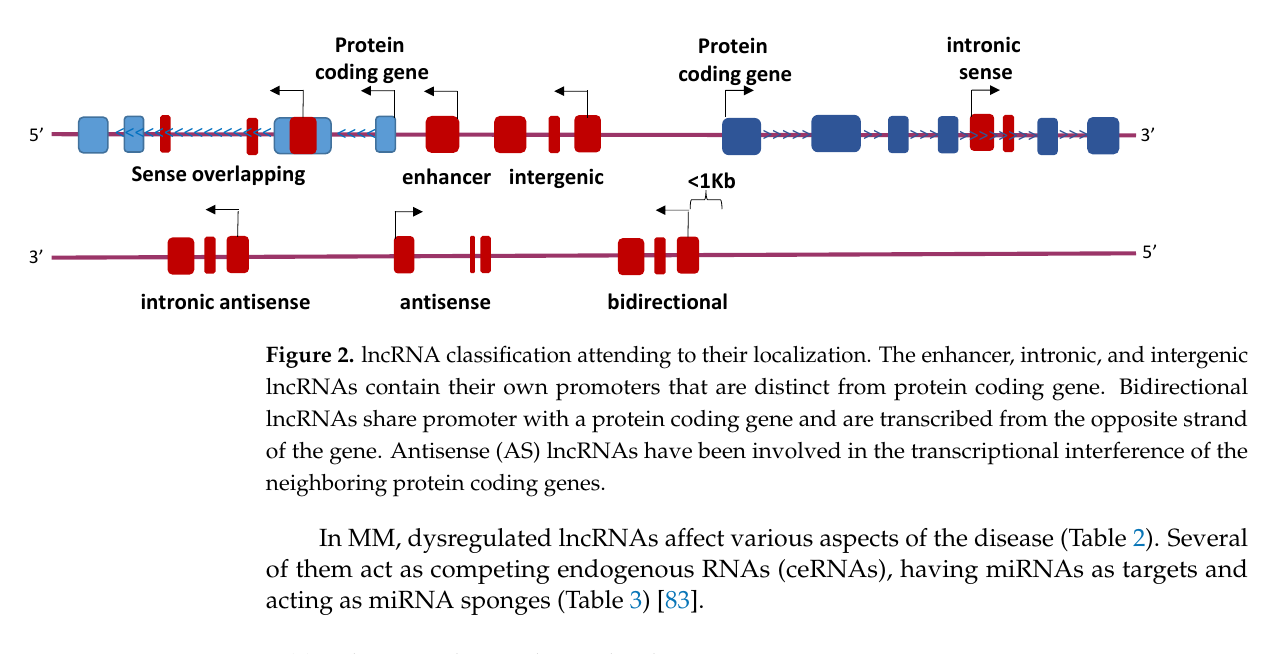
Figure 2. lncRNA classification attending to their localization. The enhancer, intronic, and intergenic lncRNAs contain their own promoters that are distinct from protein coding gene. Bidirectional lncRNAs share promoter with a protein coding gene and are transcribed from the opposite strand of the gene. Antisense (AS) lncRNAs have been involved in the transcriptional interference of the neighboring protein coding genes.